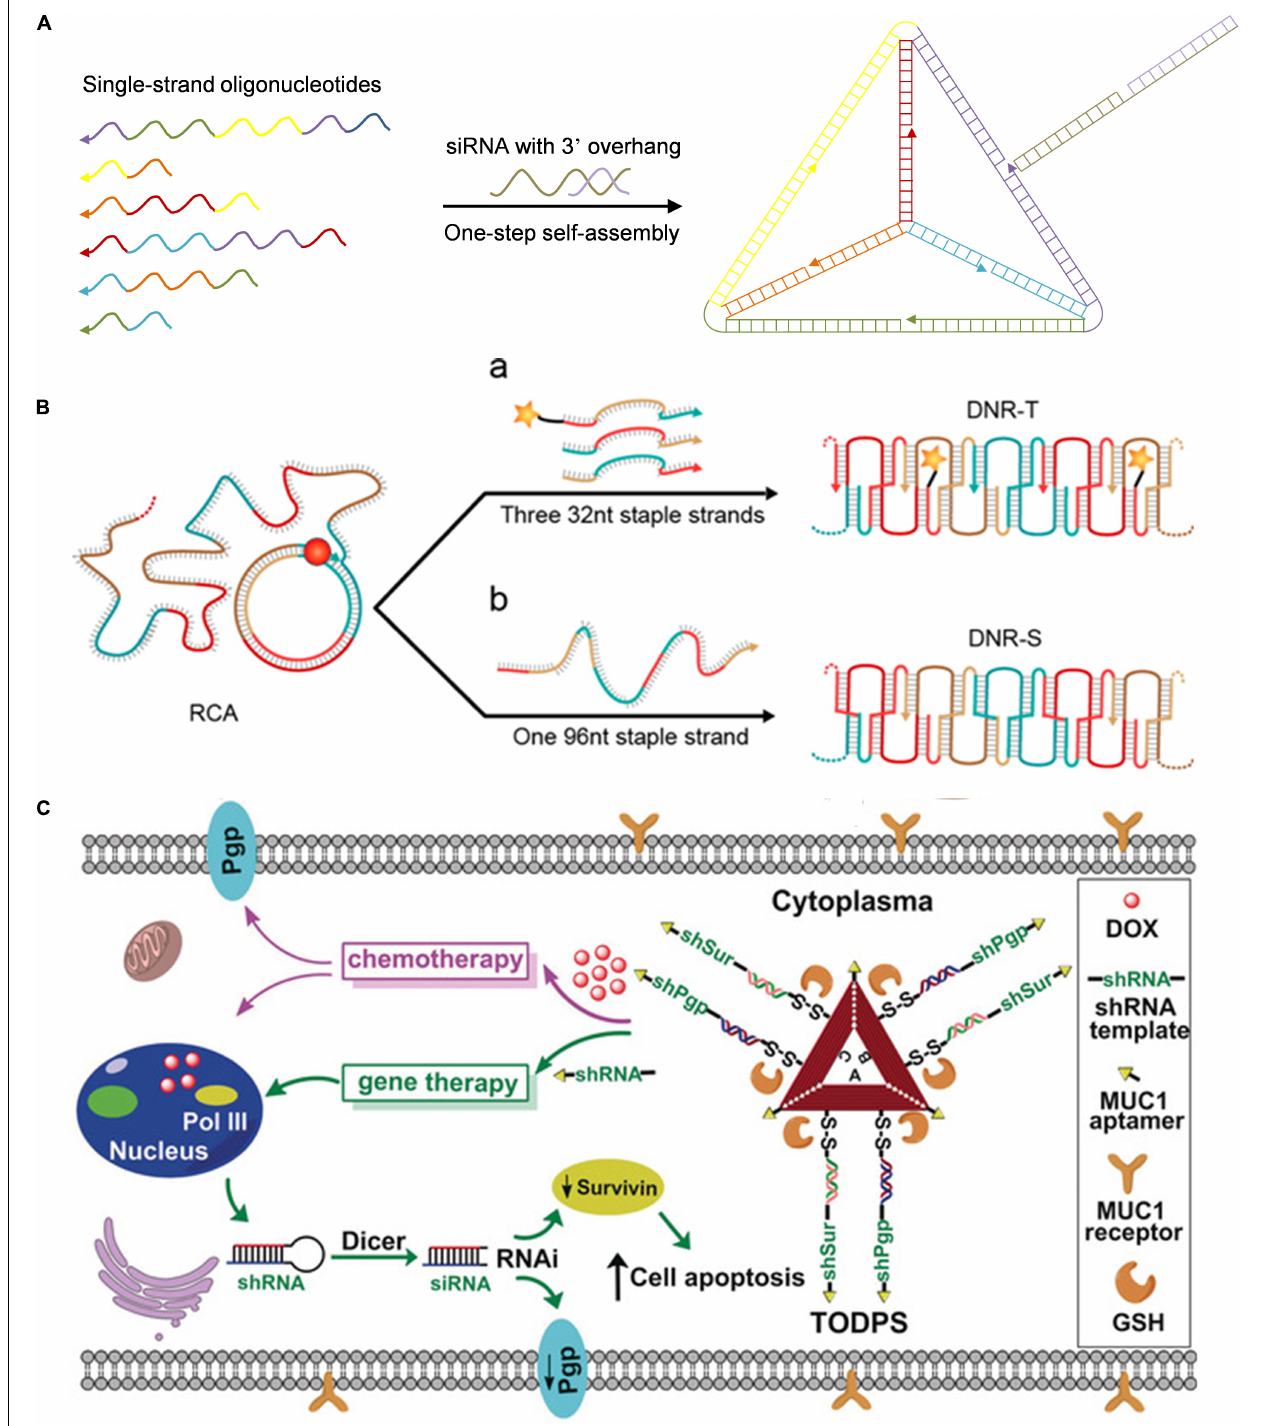
FIGURE 2 | Pure DNA nanoassembly for nucleic acid-based drugs delivery. (A) DNA tetrahedron for targeted in vivo siRNA delivery. Adapted with permission from ref. Lee et al. (2012). (B) DNA nanoribbons for siRNA delivery. Adapted with permission from ref. Chen et al. (2015). Copyright 2015, American Chemical Society. (C) DNA origami for synergistic RNAi-/chemotherapy. Adapted with permission from ref. Liu et al. (2018). Copyright 2018, Wiley-VCH.